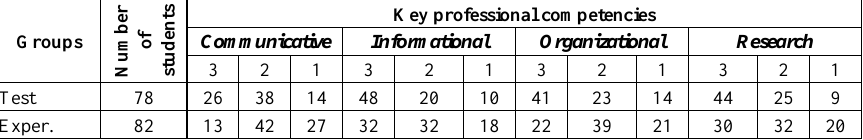
Table 3. Levels of professional competencies’ formation after the experiment